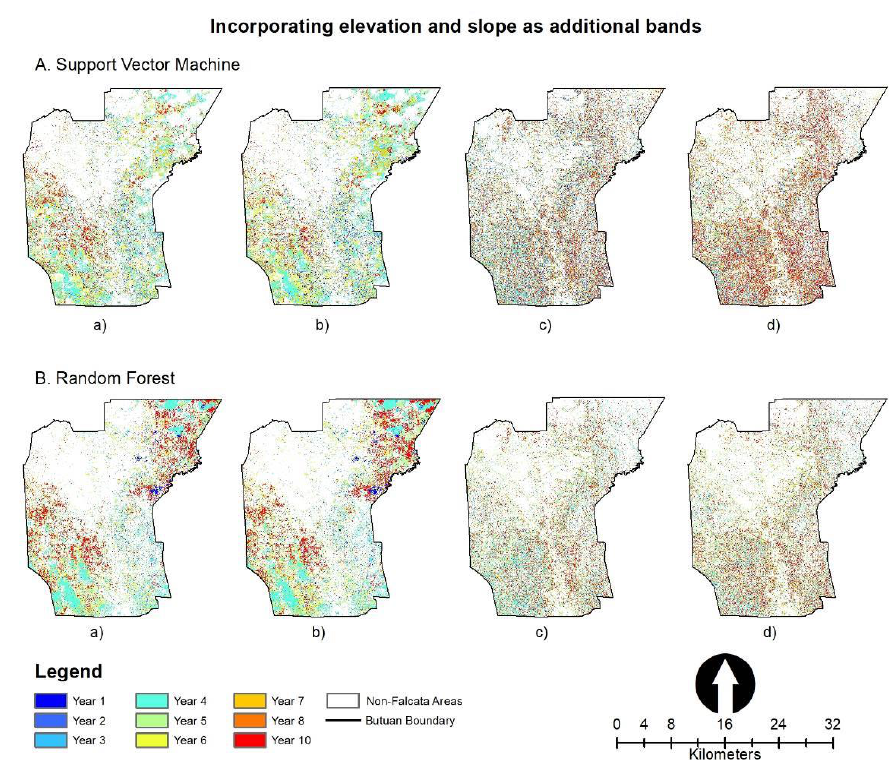
Figure 6. Classification results for Falcata stand ages incorporating elevation and slope as additional bands to the following data layers: a) Multitemporal Sentinel-1 and Sentinel-2 data with VIs, b) Multitemporal Sentinel-2 data with VIs c) Single Year Sentinel-1 and Sentinel-2 data with VIs, d) Single Year Sentinel-2 data with VIs.